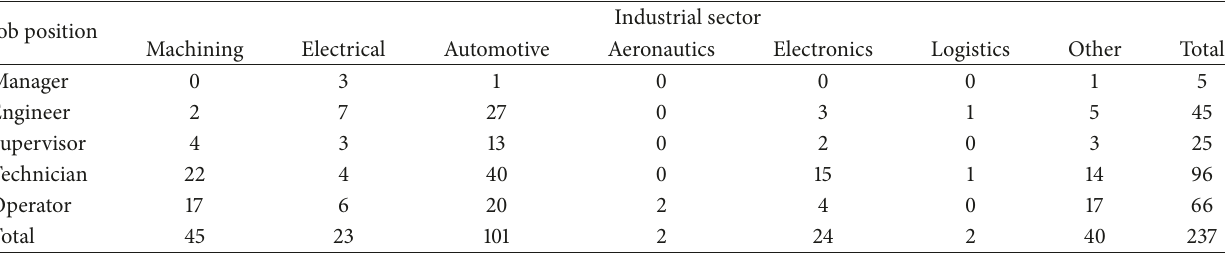
Table 2: Contribution of work position and industrial subsector.